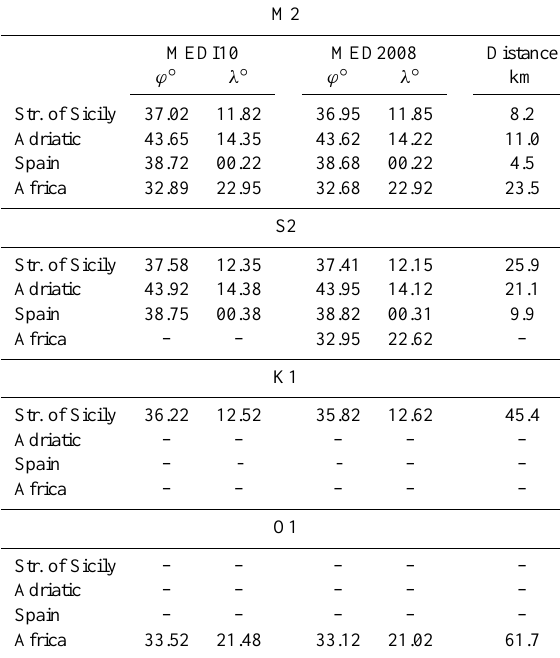
Table 13. Comparison of the position of amphidromes appeared in MEDI10 and MED2008.